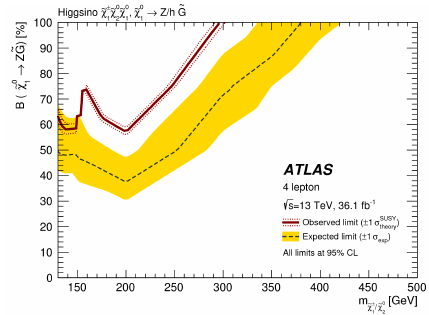
Figure 27: RPC GGM higgsino [ 21 ]